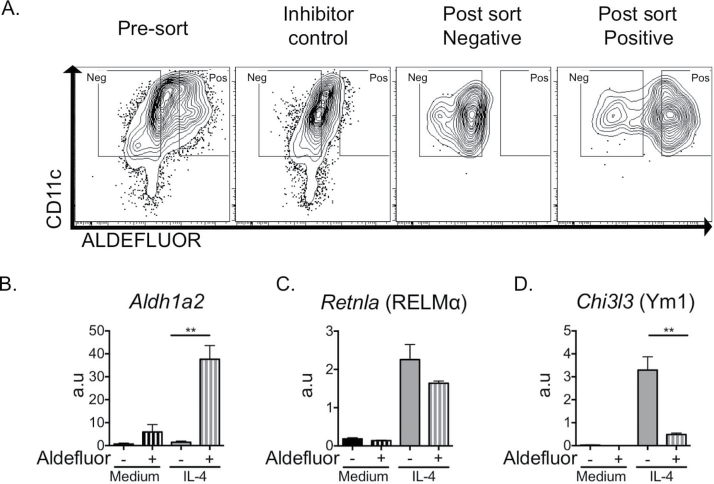
IL-4-induced DC aldehyde dehydrogenase activity correlates with expression of RELMα but not Ym1. Following overnight culture with IL-4, BMDC populations were sorted by flow cytometry based upon aldefluor activity (A) and quantitative PCR was used to assess expression of Aldh1a2 (B), Retnla (C) and Chi3l3 (D). Data are representative of 4–5 independent experiments. Error bars represent triplicate culture wells, a.u. = arbitrary units as compared with Hprt expression. **P < 0.01.